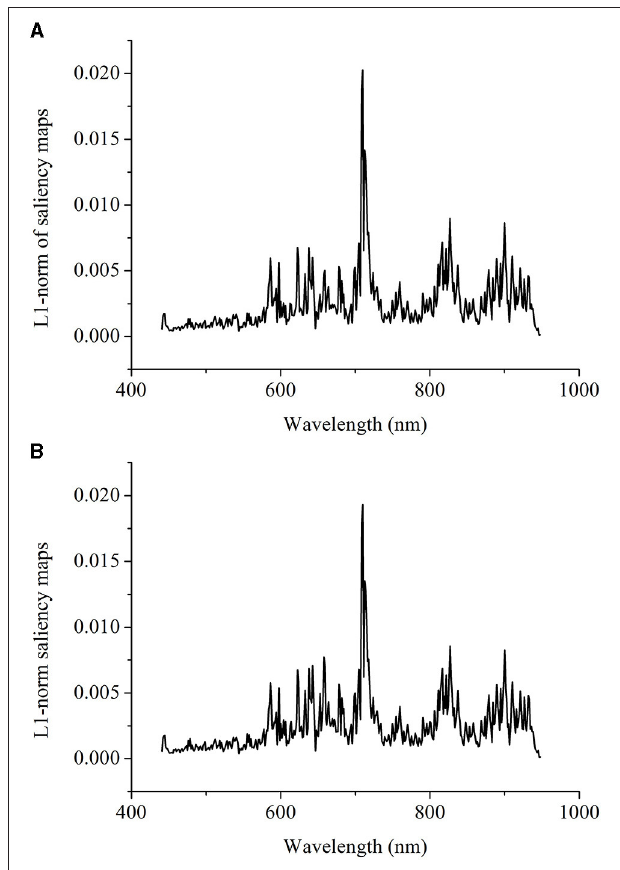
FIGURE 9 | Visualization of the wavelength contribution of the testing set for the soluble solids content (SSC) determination by 1D ResNet using samples with prediction error rate of 5% (A) and prediction error rate of 10% (B) . The prediction error rate means the ratio of differences between measured value and predicted value to the measured